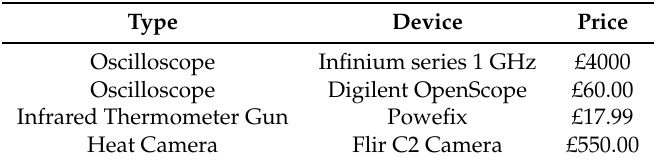
Table 1. Description of Off-The-Shelf Hardware for Hardware Trojan